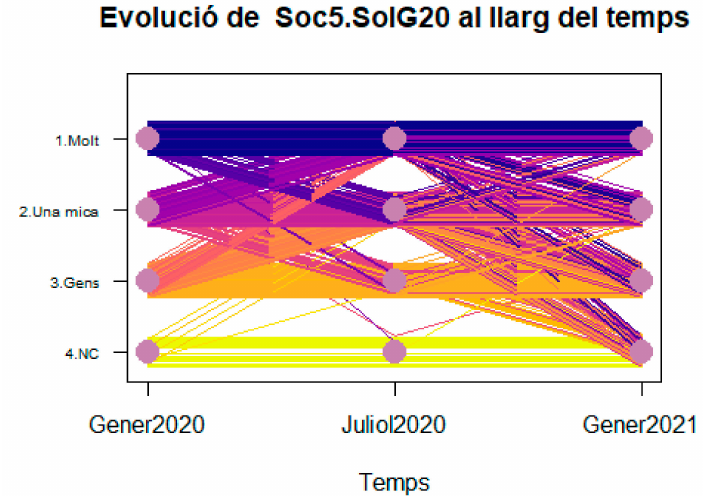
Figure 39. Trajectory map of loneliness feelings.